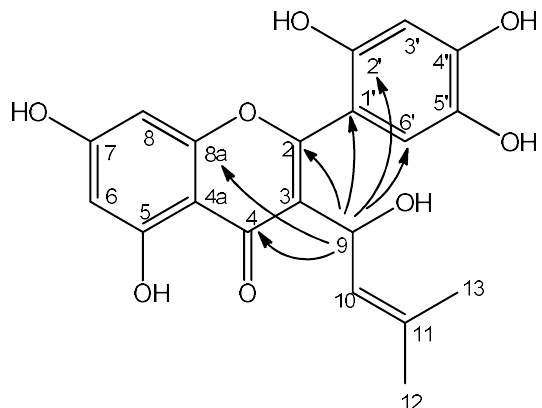
Figure 3. HMBC correlations (from H to C) of compound 2 .